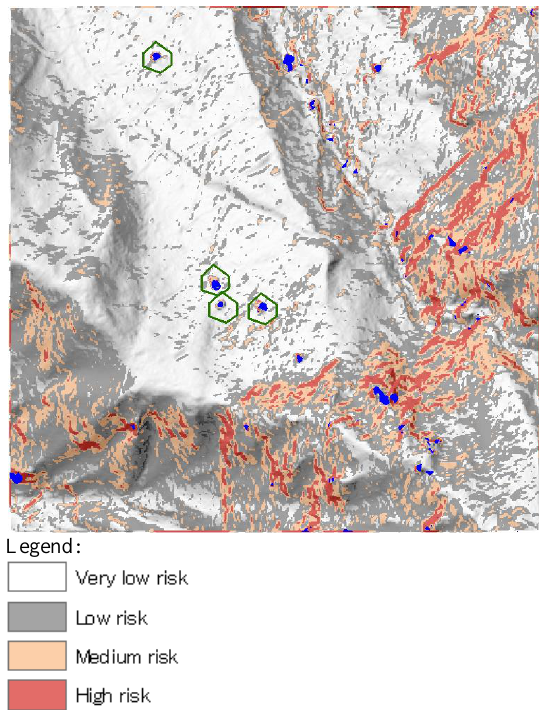
Figure 3. Rock-fall hazard risk map with protruded rock locations